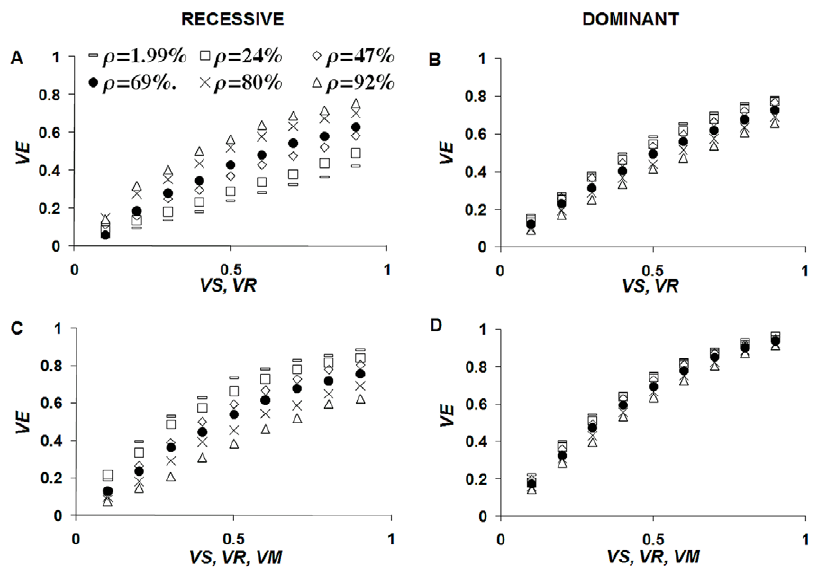
Figure 4. Impact of multi-target vaccines. Vaccines simultaneously reducing fecundity ( VR ) and susceptibility ( VS ) (panels A–B) or fecundity, susceptibility, and parasite life-span ( VM ) (panels C–D) have the greatest potential. In this example, it is assumed that the vaccine reduces by the same proportion female worm fecundity, host susceptibility, and parasite lifespan. A and C refer to recessive alleles, B and D refer to dominant alleles.